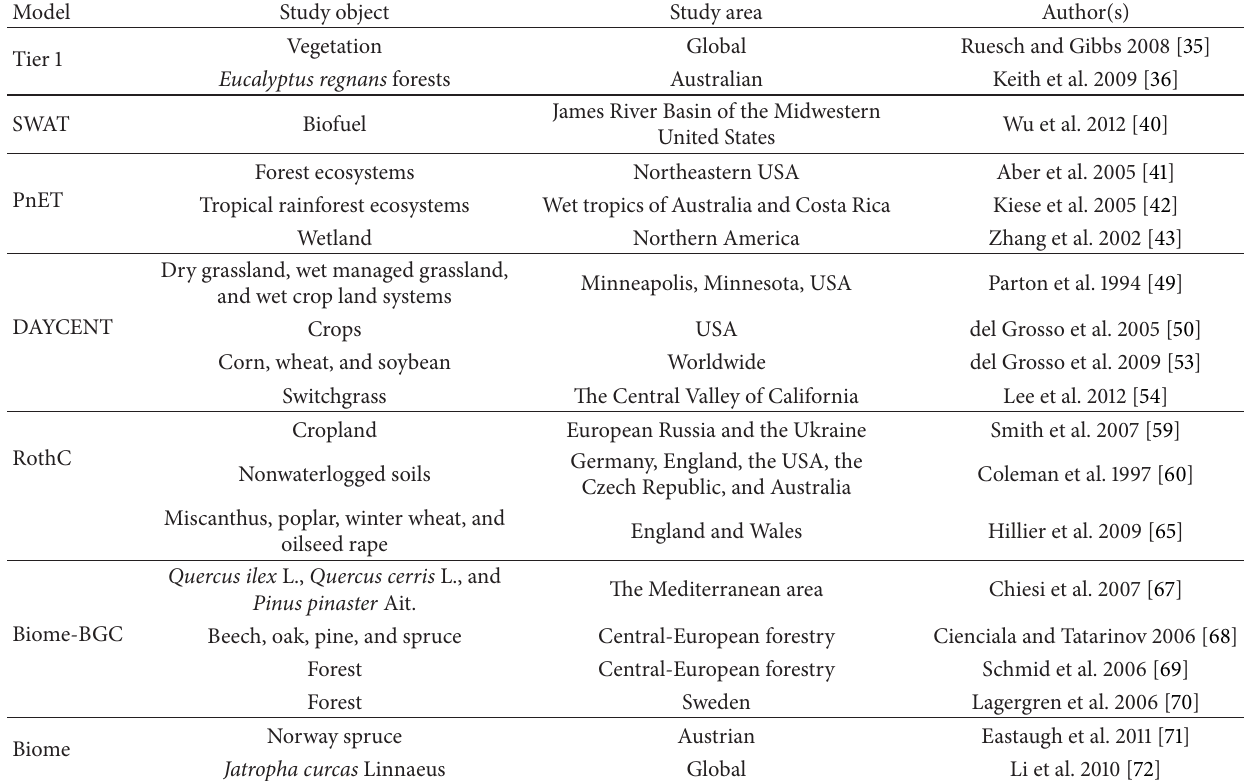
Table 1: Models mostly used for GHG simulation of energy